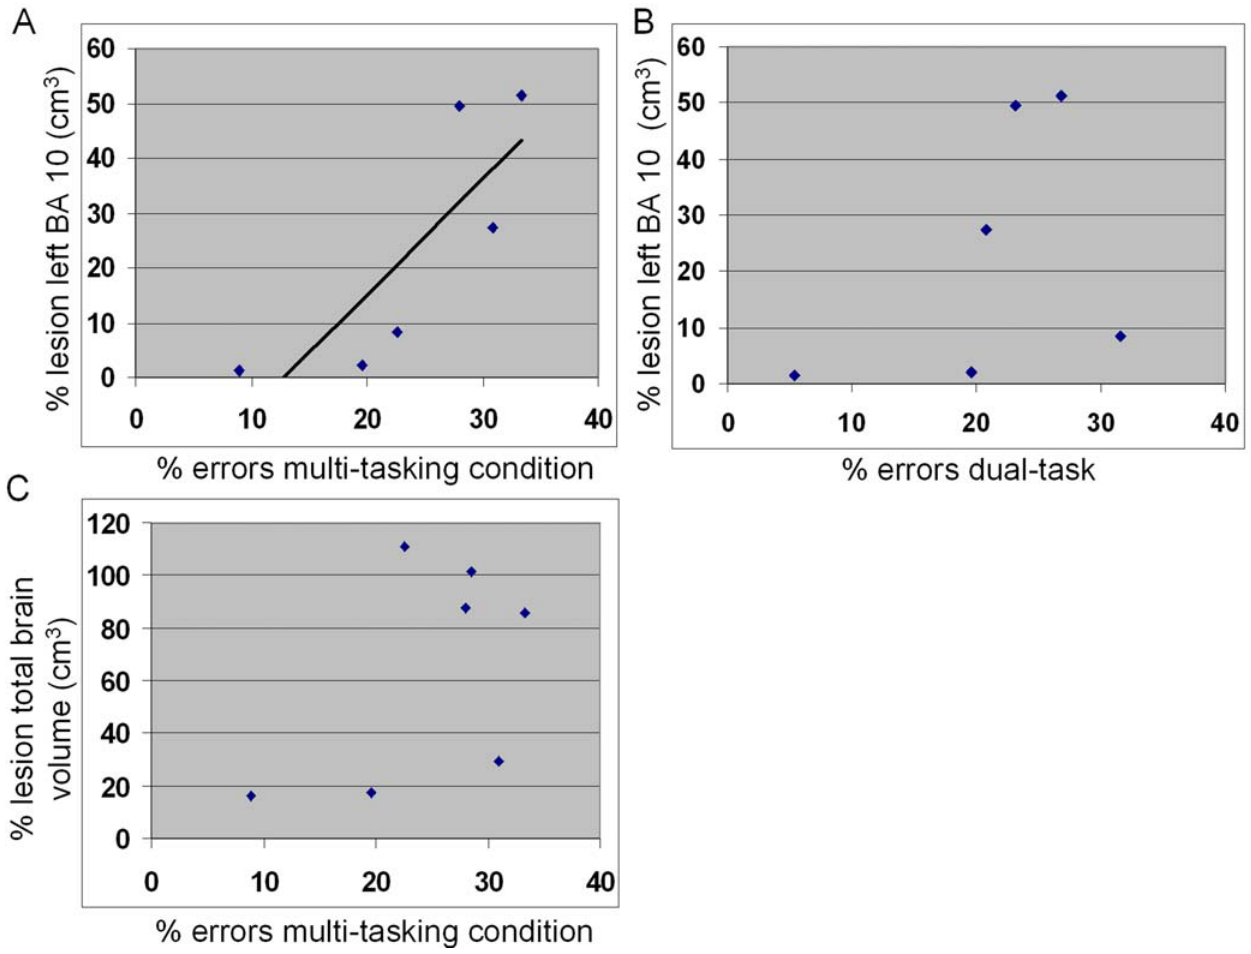
Figure 6. Relationships between lesion size and behavior. (A) A positive significant correlation was observed between the percentage of errors in the multi-tasking condition and the percentage of damage to the left Brodmann’s area 10 in patients with fronto-polar cortex lesions (Spearman rank correlation coefficient R=0.94, P , 0.005). (B) No significant correlation was observed between the lesion sizes of the left BA 10 with error rate in the dual-task condition. (C) No significant correlation was observed between total volume of brain lesions and error rate in the multi- tasking condition.